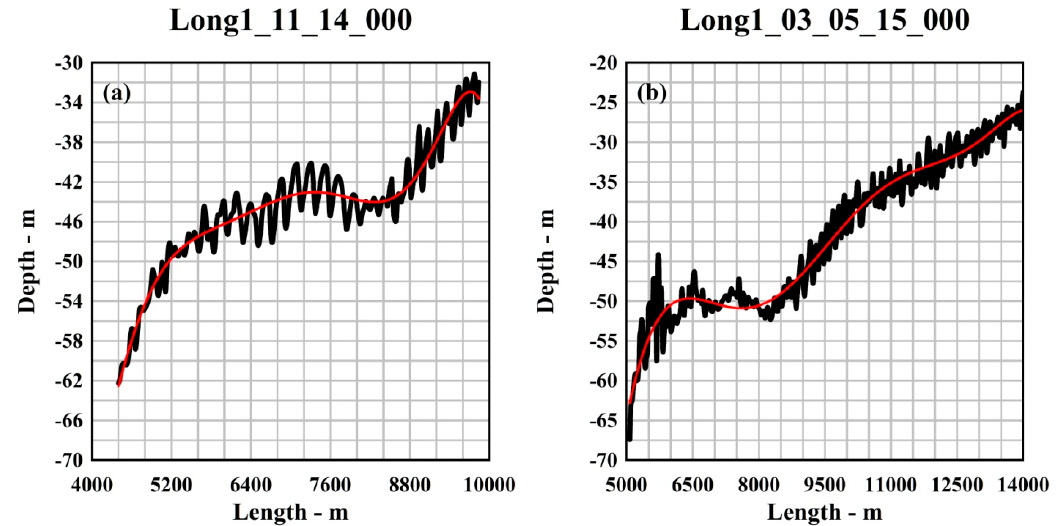
Figure 8. Polynomial seventh grade fit and longitudinal transects for (a) FS − CNS1 and (b) FS − CNS2.